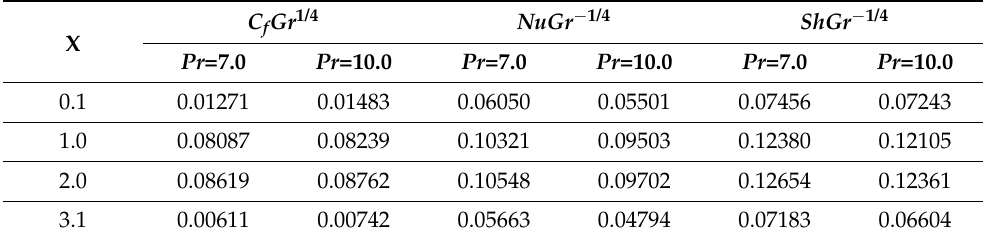
Table 2. Outcomes of the Prandtl number Pr on (a) the skin friction coefficient C f Gr 1/4 , (b) Nusselt NuGr − 1/4 , and (c) the Sherwood number ShGr − 1/4 when Nt = 0.2, Nb = 10.0, N = 1.1, and Sc = 10.0.